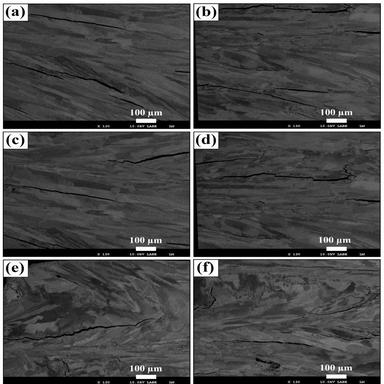
Channeling contrast FE-SEM images from (a, b) X-, (c, d) Y-, and (e, f) Z-sections of the LPBF-deposited nanocomposite structure.